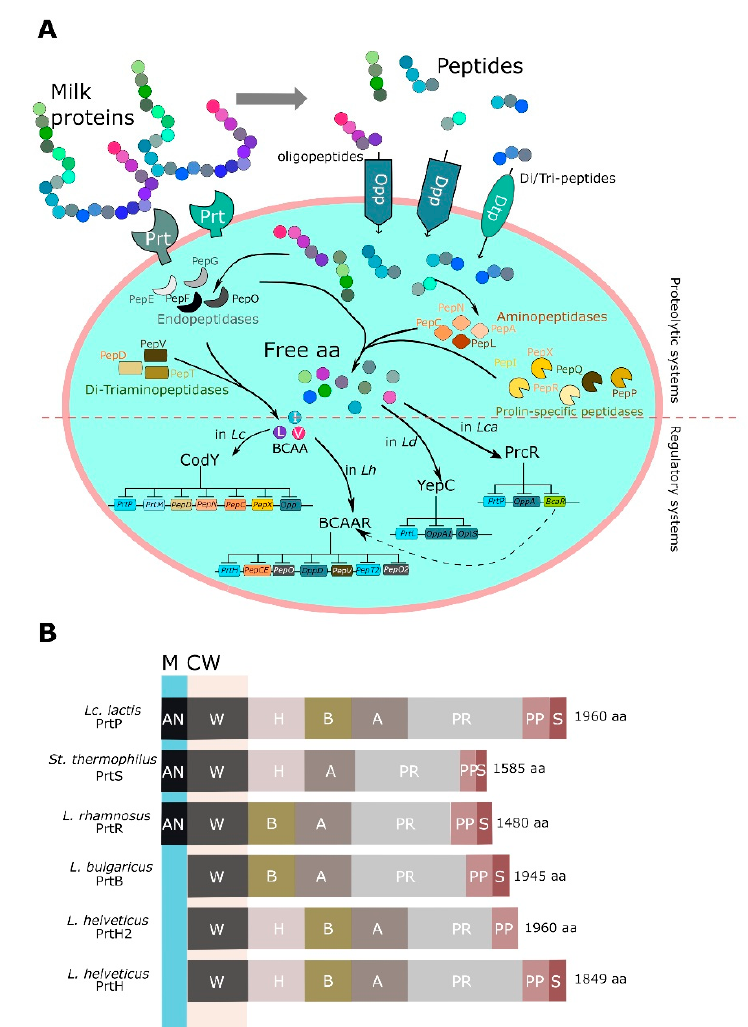
Figure 3. Comparative analysis of proteolytic systems in Lactococcus lactis and Lactobacillus spp. ( A ) Main effectors of proteolytic machinery and regulatory systems. ( B ) Multi-domain structure of prt proteinases isolated from Lactococcus lactis , Streptococcus thermophilus , and Lactobacillus spp.